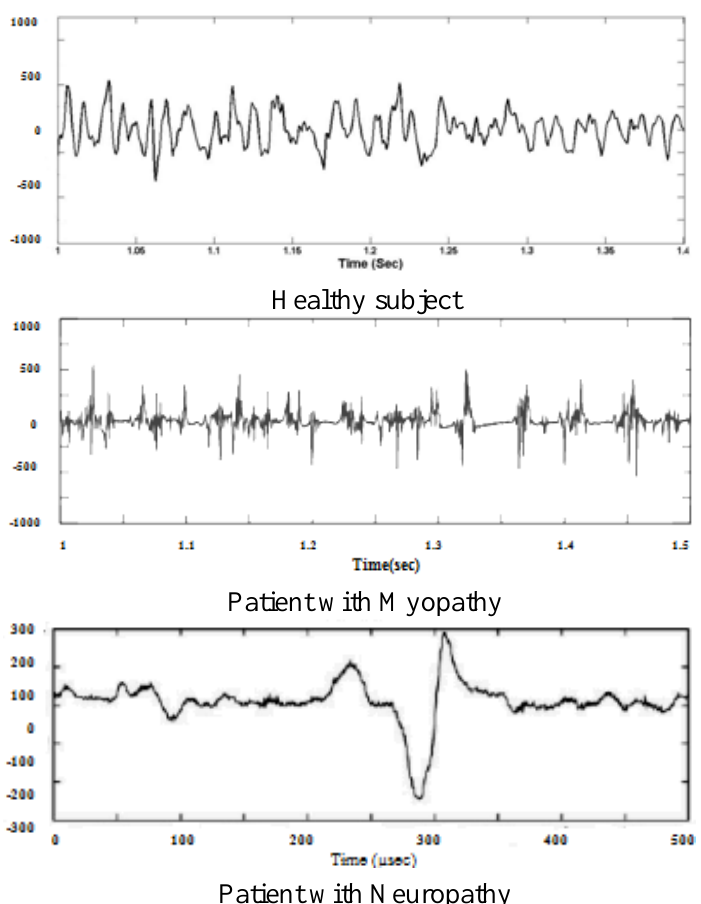
Figure 11. Three types of EMG signals; here y-axis represents amplitude (µV)